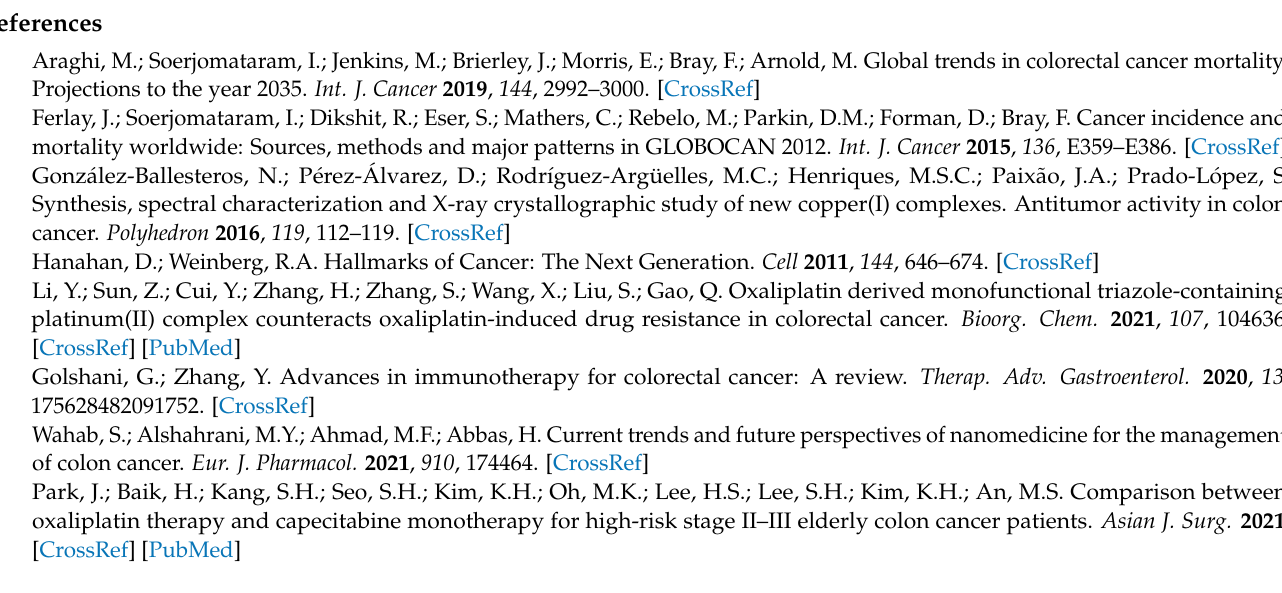
PXRD; Figure S5–S8: Topological analysis; Figure S9: Hirshfeld surface mapped over; Figure S10: 2D fingerprint